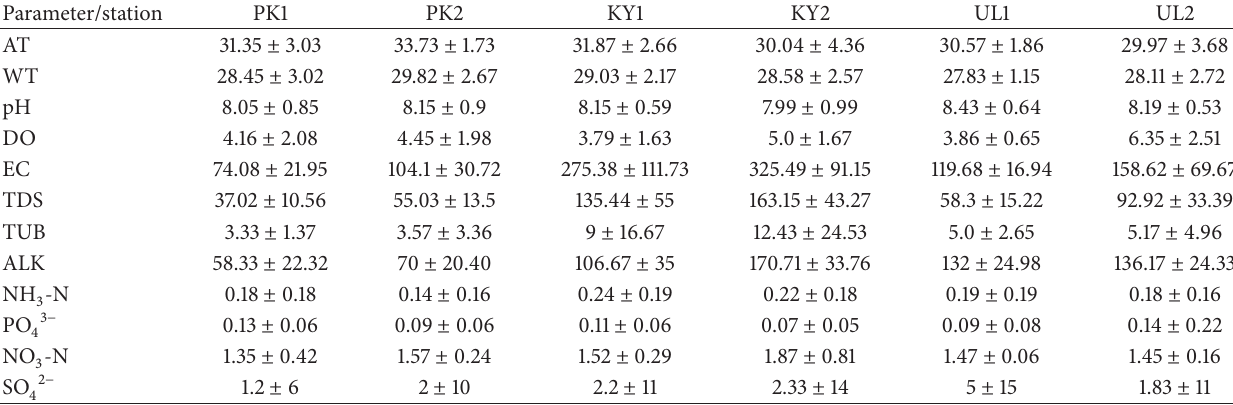
Table 2: Mean values ( ± SD) of environmental variables in each sampling